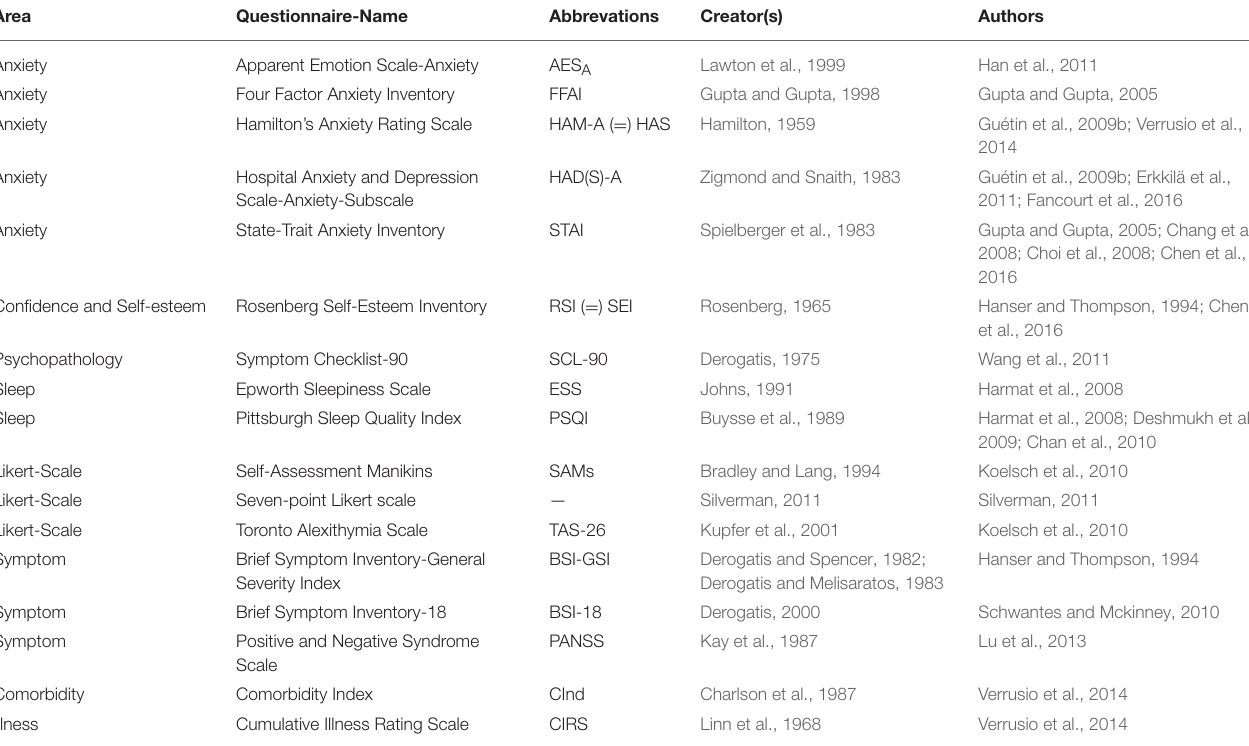
TABLE 5 | Additional tests, conducted by researchers within our selection for investigating changes in other